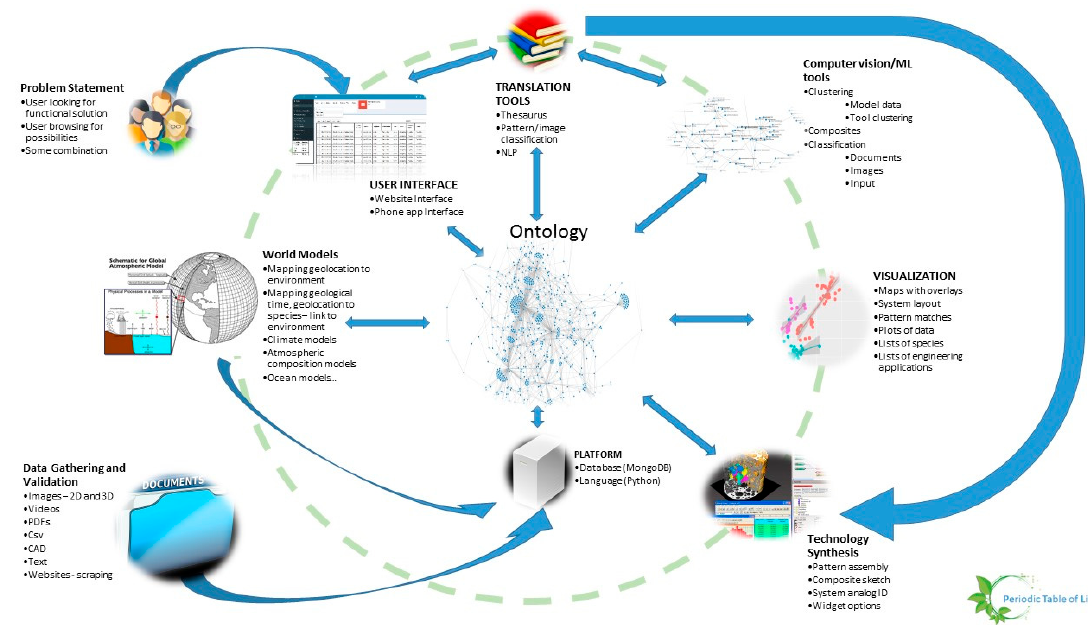
Figure 13. PeTaL Figure 13. PeTaL architecture.